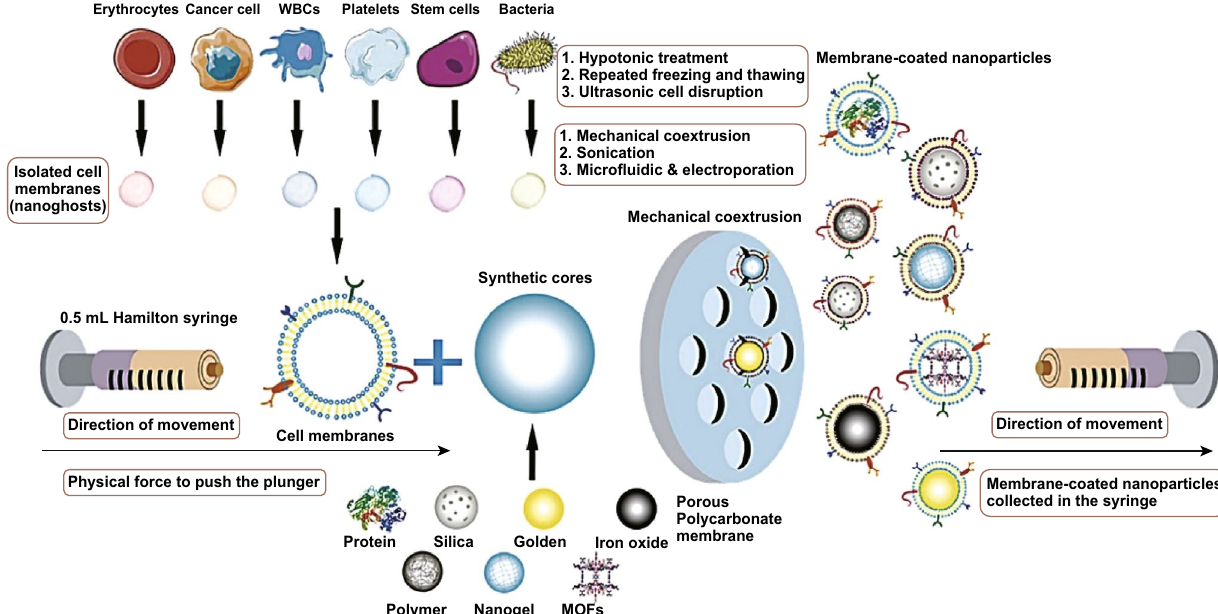
Fig. 1 Membrane coating via physical co‑extrusion approach. After obtaining appropriate cell membranes via hypotonic isolation, repeated freeze/thawing, or ultrasonic disruption, synthetic NP cores are co‑extruded through a porous polycarbonate membrane. Adapted from Ref. [23] with